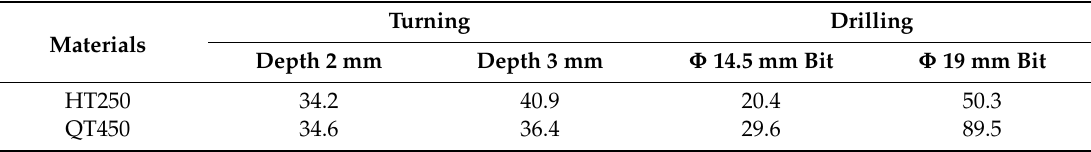
Table 3. The surface roughness in μ m.